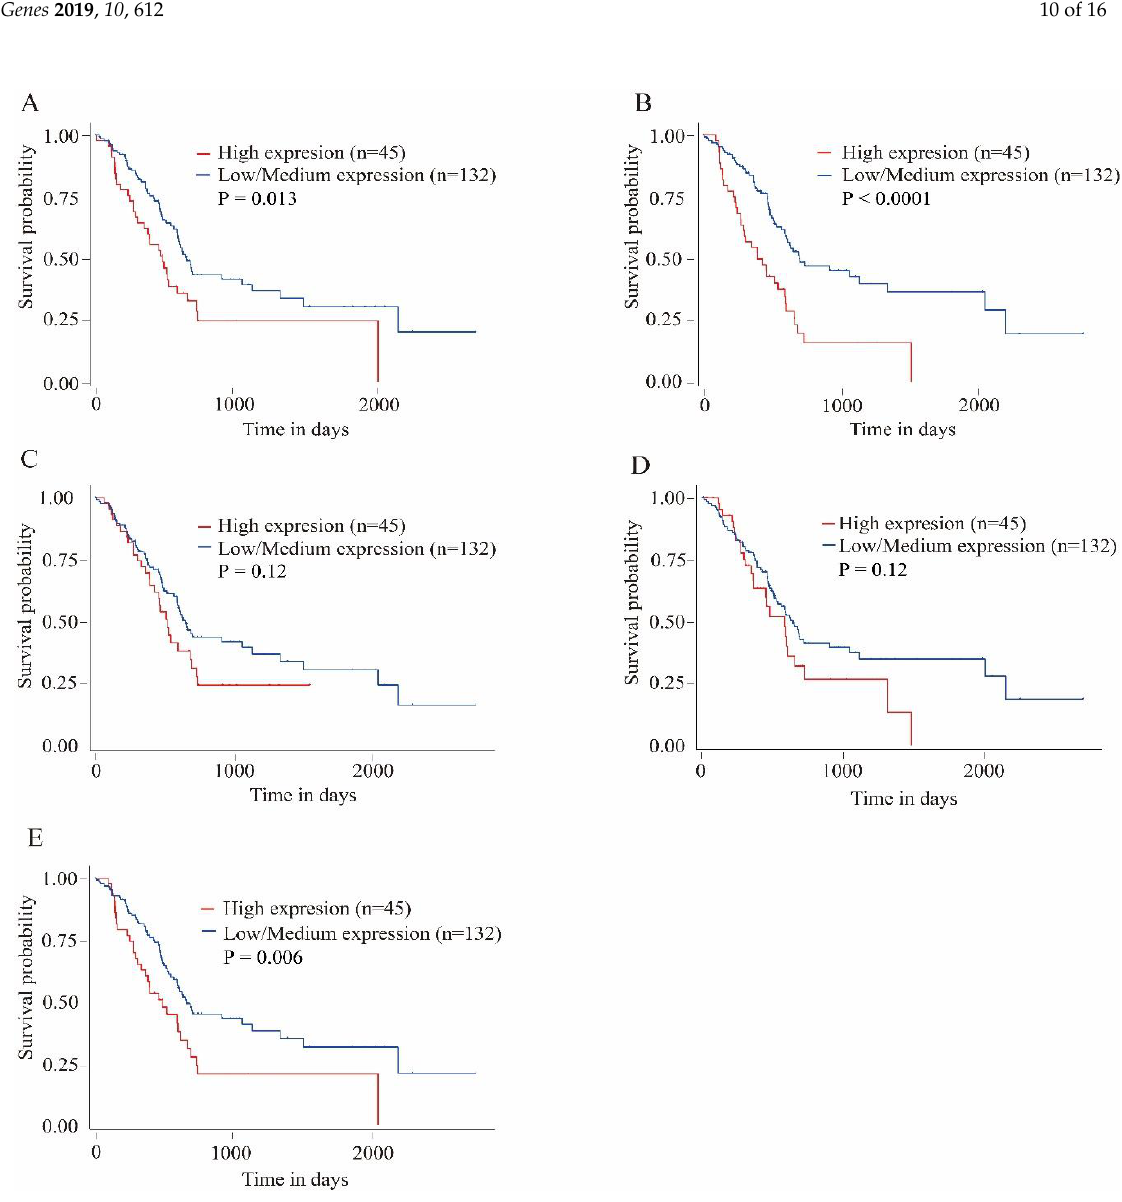
Figure 5. Kaplan–Meier plots showing the association of hub genes expression levels with patient survival. ( A ) Proto-oncogene receptor tyrosine kinase Met ; ( B ) Maternal embryonic leucine zipper kinase ; ( C ) syndecan 1 ; ( D ) thrombospondin 1 ; ( E ) DNA topoisomerase II alpha .